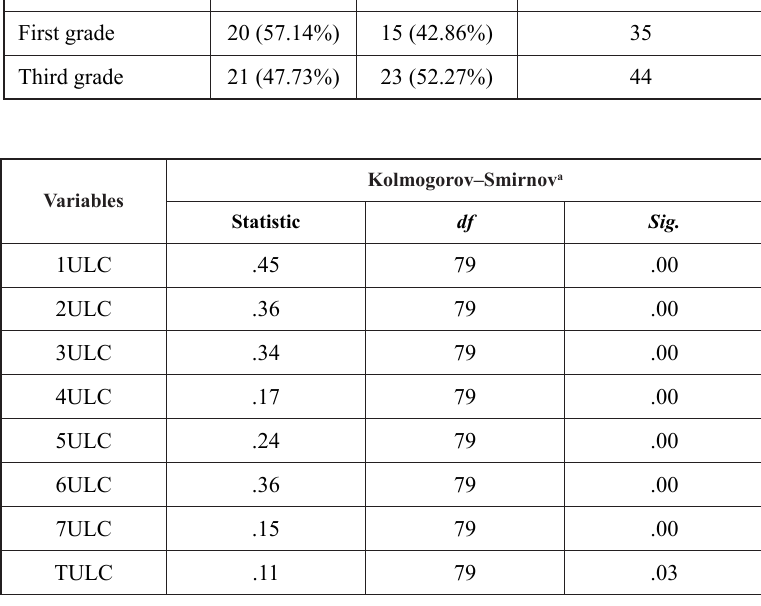
Table 1. Number and percentage of sample by gender